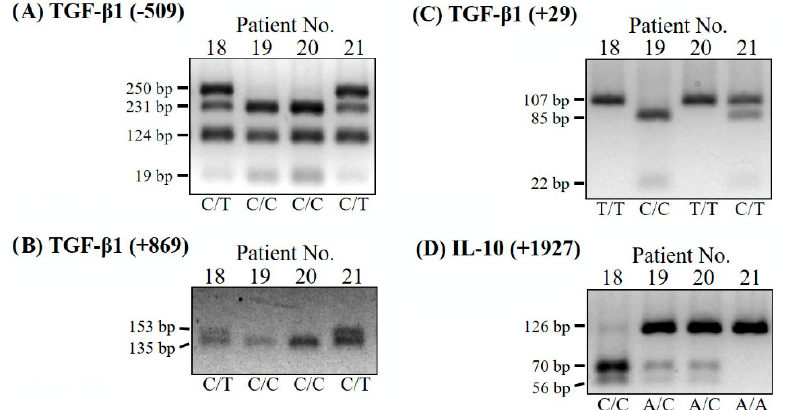
Figure 1. Representative electrophoresis gel images of the PCR-RFLP analysis of Taiwanese osteo- porotic patients. The different single-nucleotide polymorphisms (SNPs) of ( A ) TGF- β 1 ( − 509 C/T), ( B ) TGF- β 1 (+869 T/C), ( C ) TGF- β 1 (+29 T/C) and ( D ) IL-10 (+1927 A/C) are shown for patients No. 18 to No. 21.